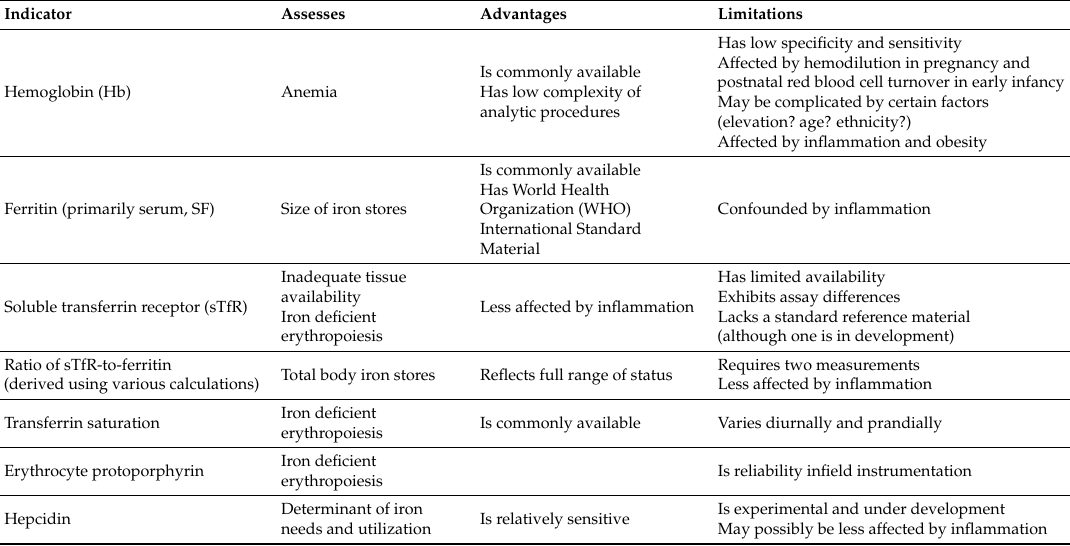
Table 3. Commonly used indicators of iron status in pregnancy and infancy 1